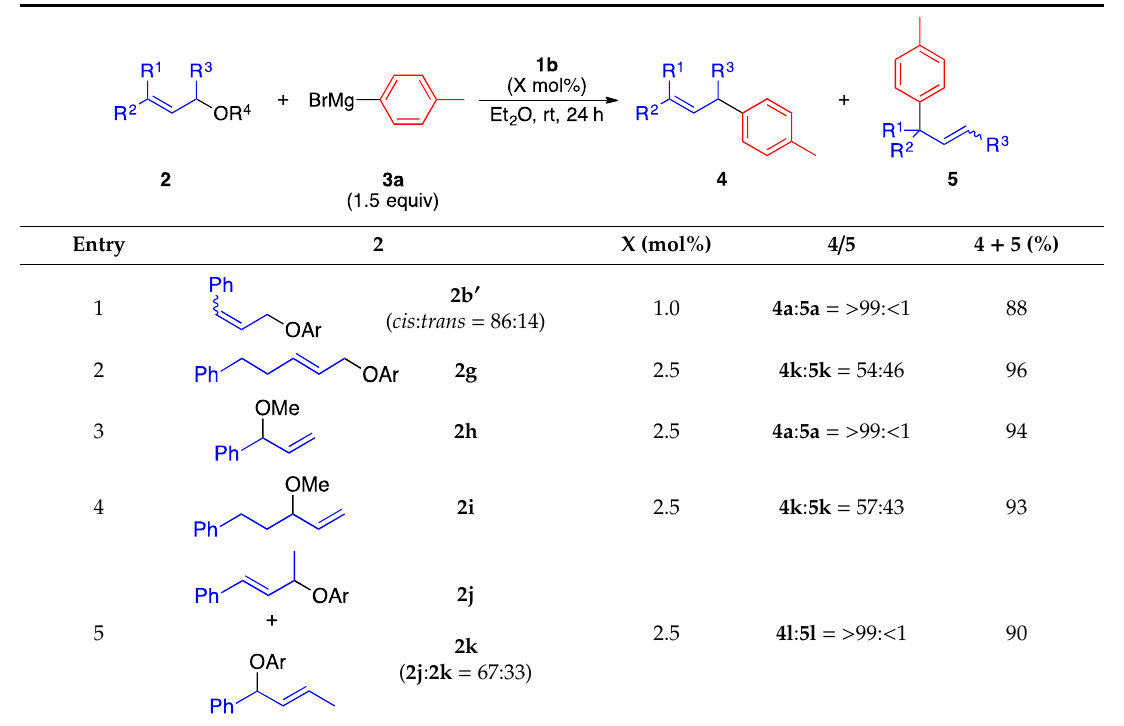
a The reaction was carried out using 2 (0.5 mmol) and 3 (0.75 mmol) in the presence of 1b (0.005